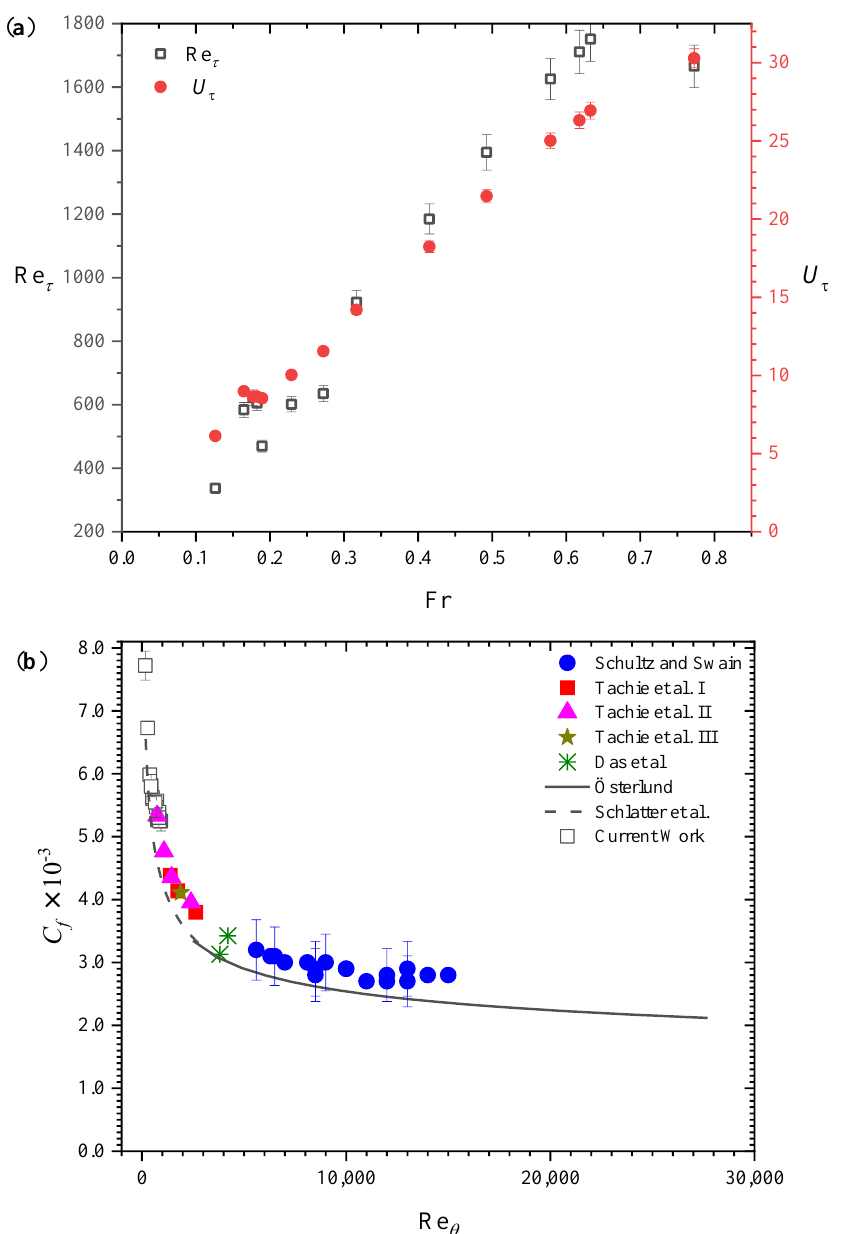
Figure 6. ( a ) Dependence of friction velocity U τ and friction Reynolds number Re τ on the Froude number Fr. ( b ) Skin friction coefficient C f values of current tests compared with other open-channel flow studies (Schultz and Swain [17]; Tachie et al. I [4], II [6], III [18] and; Das et al. [19]) and other boundary layer studies (Ö sterlund [15] and Schlatter et al. [16]).